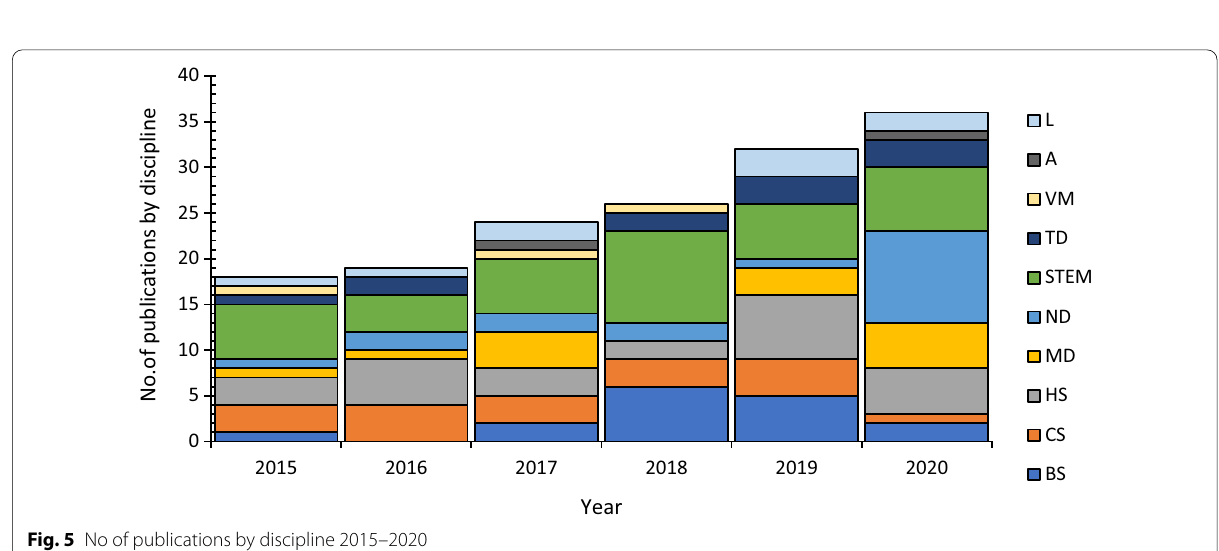
Fig. 4 Vosviewer cluster graphic of keyword results: a Keywords with more than 3 uses, b The links highlighted when the word ‘education’ is